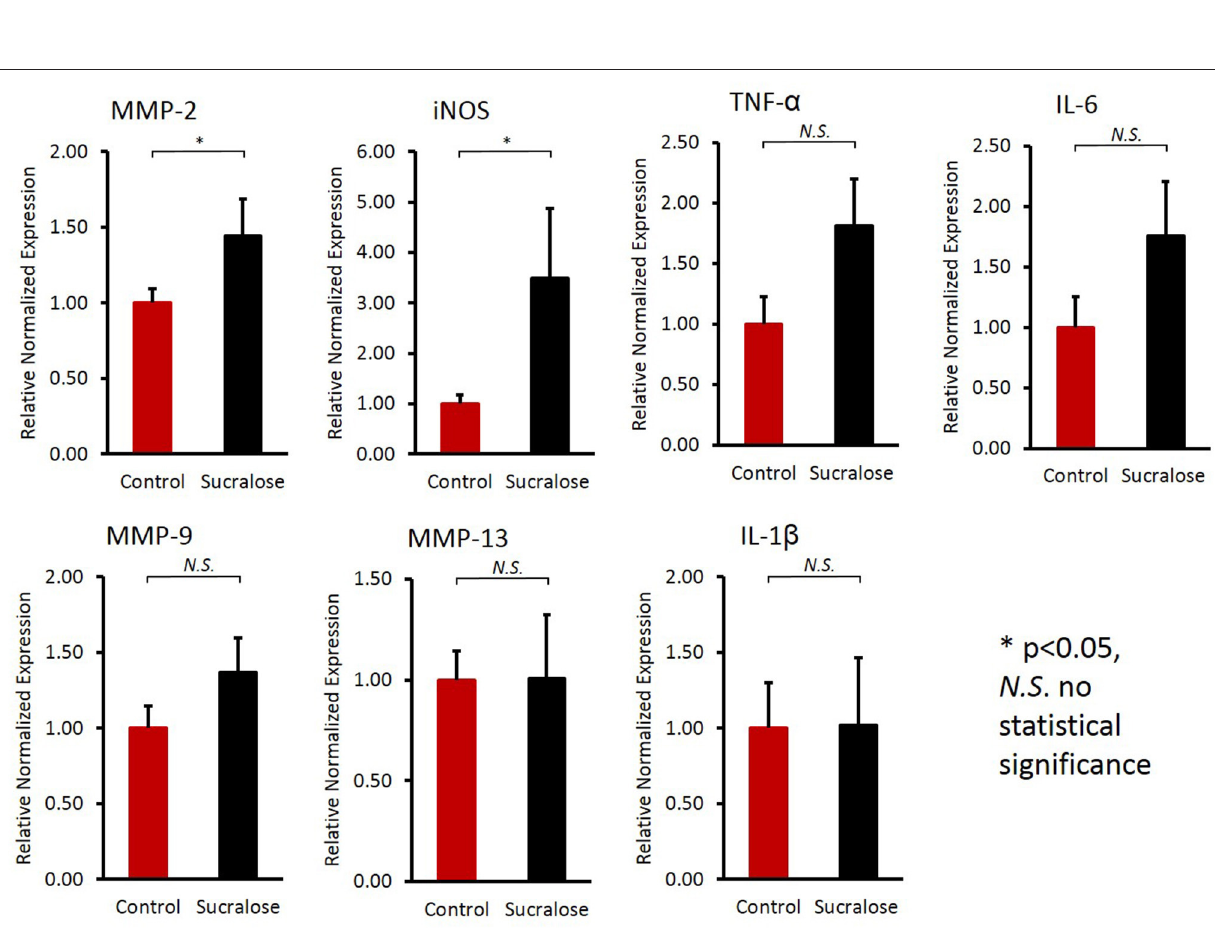
Frontiers in Physiology |